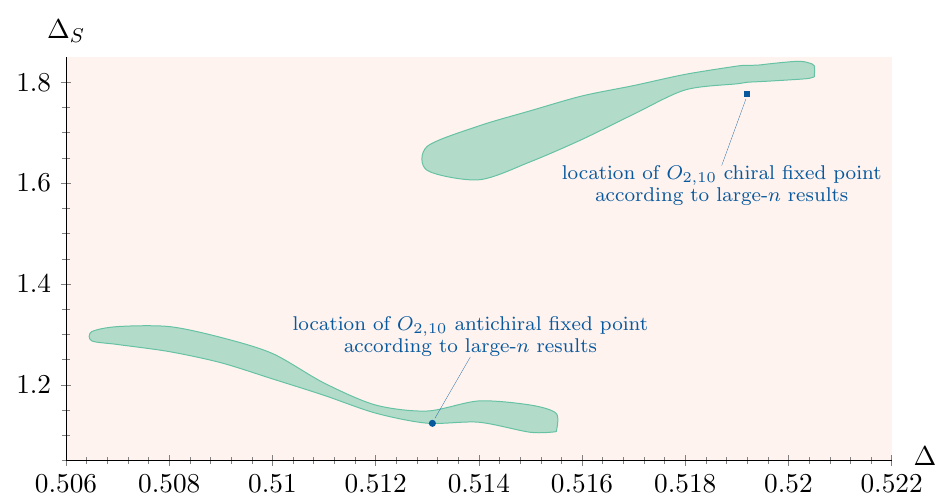
Figure 8: Allowed region (in green) for the O their location according to (9). The chiral island is obtained with the assumptions (C-1)-(C-5), while the antichiral island is obtained with the assumptions (A- O (A- O -5). 2,10